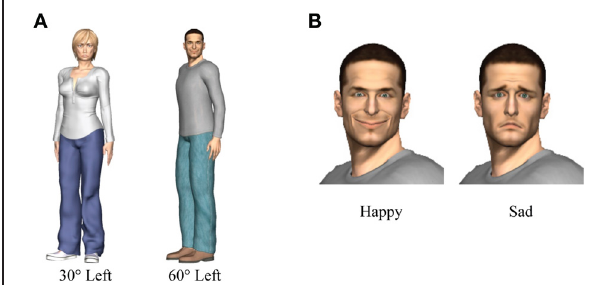
FIGURE 2 | (A) Example of a female avatar with body orientation to the left with an angle of 30 ◦ (sad facial expression) and a male avatar with body orientation to the left with an angle of 60 ◦ (happy facial expression). (B) Close-up of happy and sad facial expressions of a male avatar.